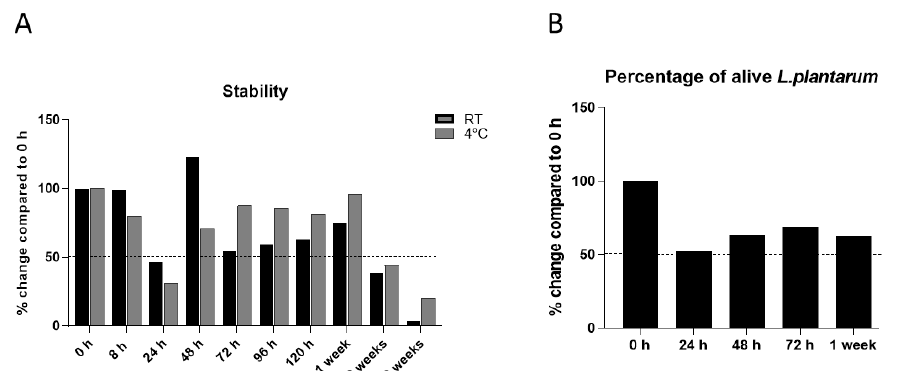
Figure 1. Viability L. plantarum expressed as a percentage respective to time 0. ( A ) The serum formulation SkinDuo TM was reconstituted with sterile water and tested for stability as CFU/mL (in percentage) at times 0, 8 h, 48 h, 72 h, 96 h, 120 h, 1 week, 2 week and 3 weeks, and compared to time 0. The viability was maintained over 1 week, except after 24 h and after 2 and 3 weeks. ( B ) The formulation was stored at RT and tested for viability with a qPCR (live dye)—Propidium monoazide (PMA) method, after 24 h, 48 h, 72 h and 1 week. For each condition the ratio of the average CFU/reaction value for PMA-qPCR samples over the average CFU/reaction value for total live bacteria was calculated as a ratio of live bacteria for each condition tested. The percentage change of viability was compared to time 0. Dashed lines represent 50% from time